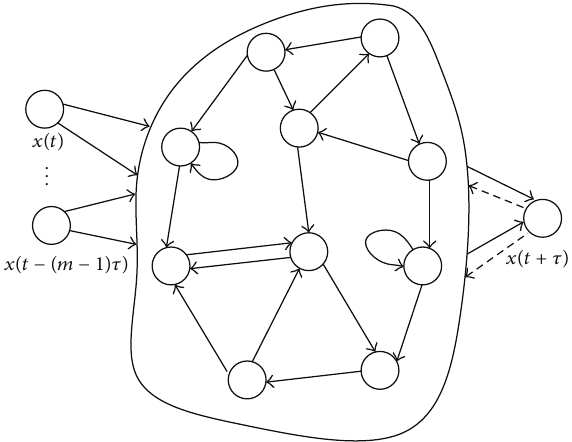
Figure 3: Architecture of echo state